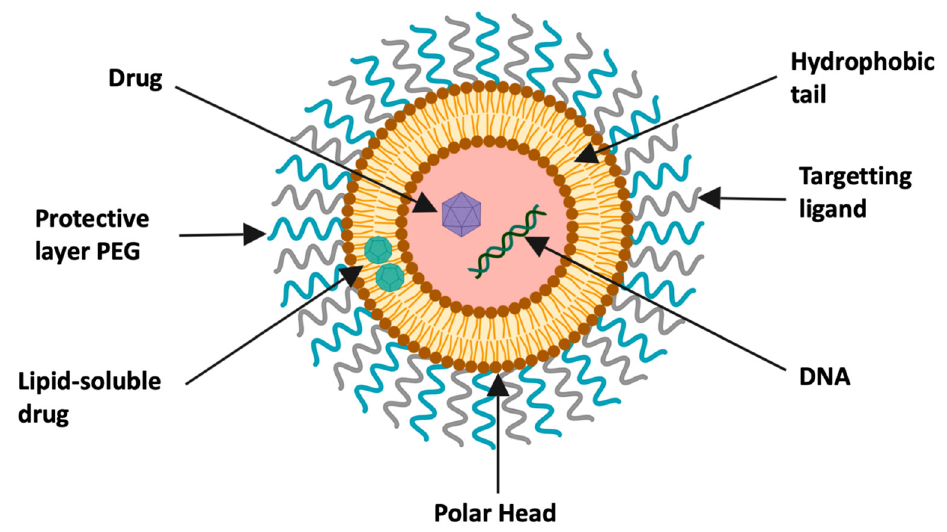
Figure 4. Schematization of a liposome used as nanovector. Liposomes generally consist of a lipid bilayer (phospholipids and cholesterol). The drug is encapsulated in the hydrophobic central region. The outer surface of the vector may contain polyethylene glycol (PEG) and ligands, created with Biorender [94].